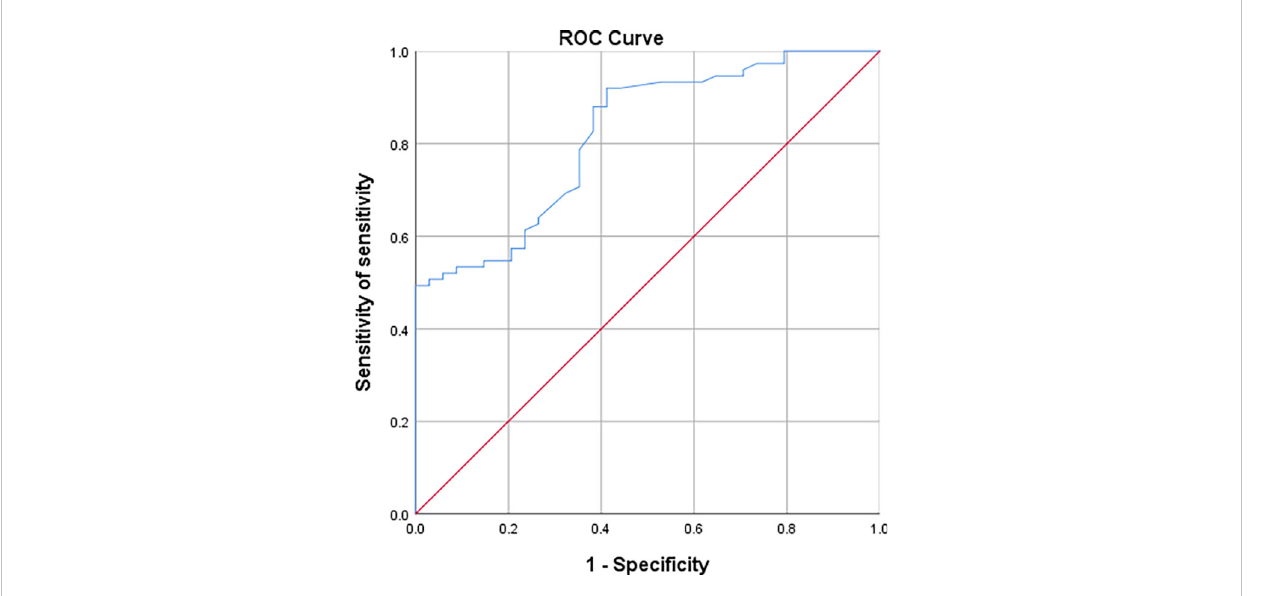
FIGURE 8 Working curves of subjects with nodal area indications differentiating AAH/AIS and